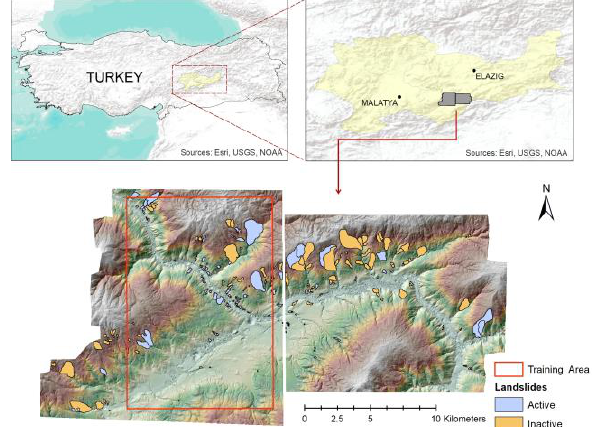
Table 1. The characteristics of the photogrammetric datasets used in the